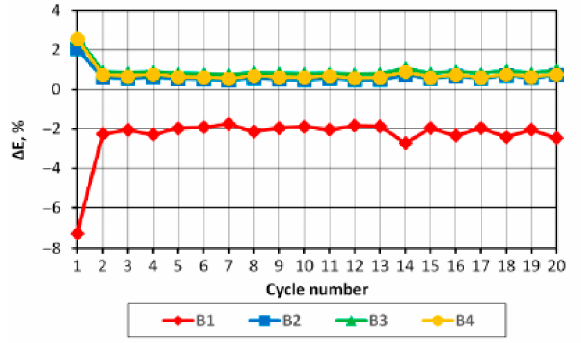
Figure 6. Differences in energy supplied by the battery in successive discharging cycles calculated in accordance with the Formula